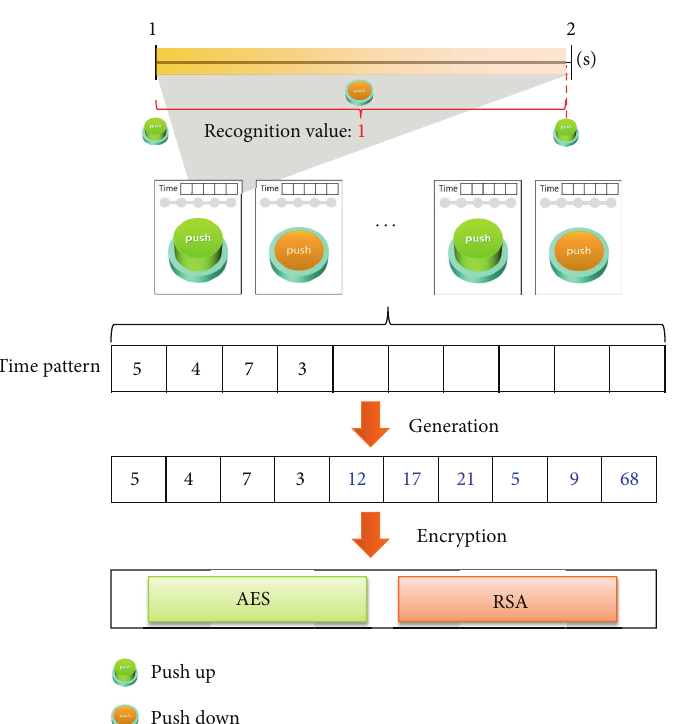
Figure 2: Time pattern recognition and encryption of SLSTP.